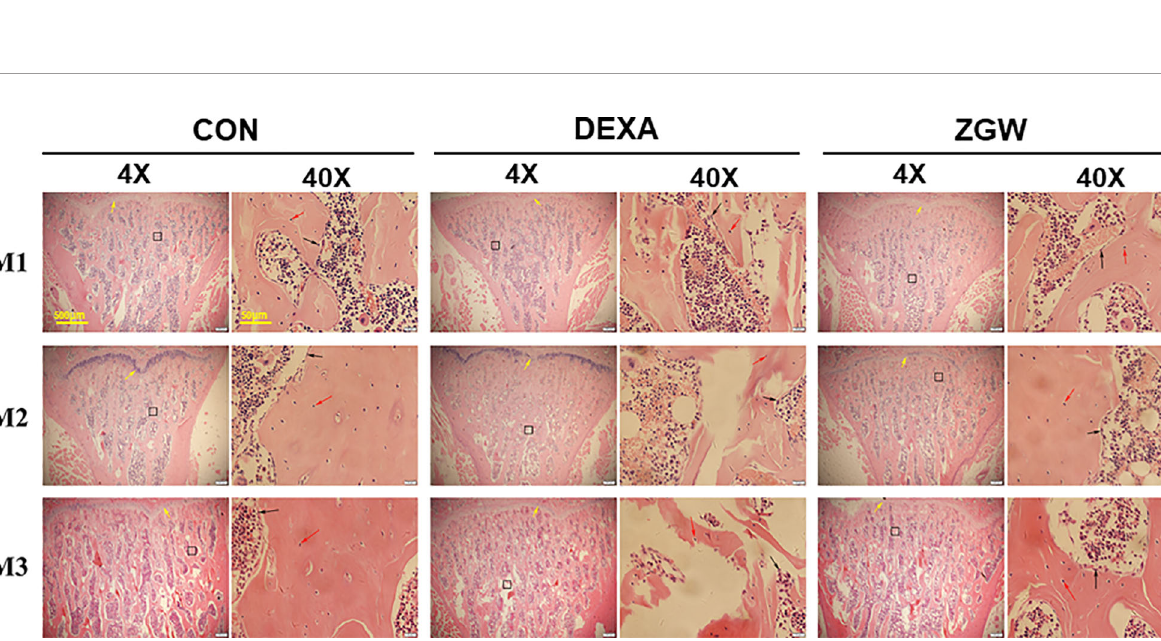
Frontiers in Endocrinology |